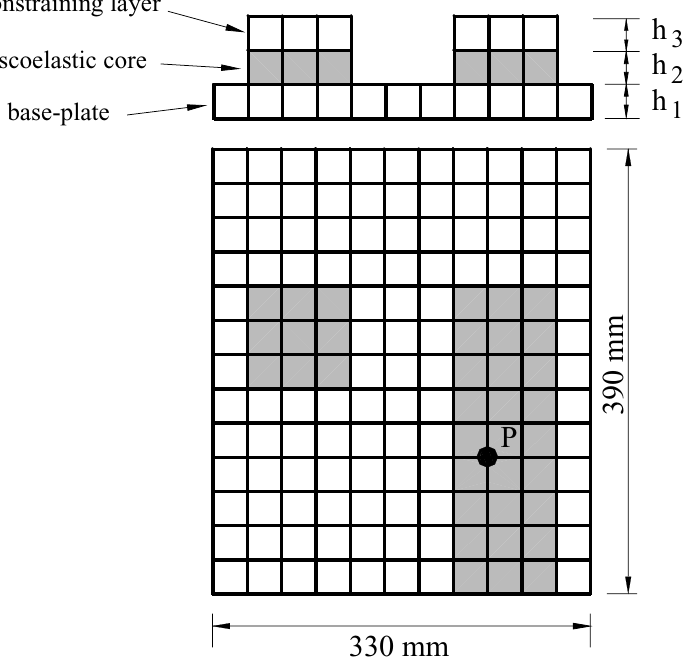
Fig. 4. FE model of the plate treated with constrained damping